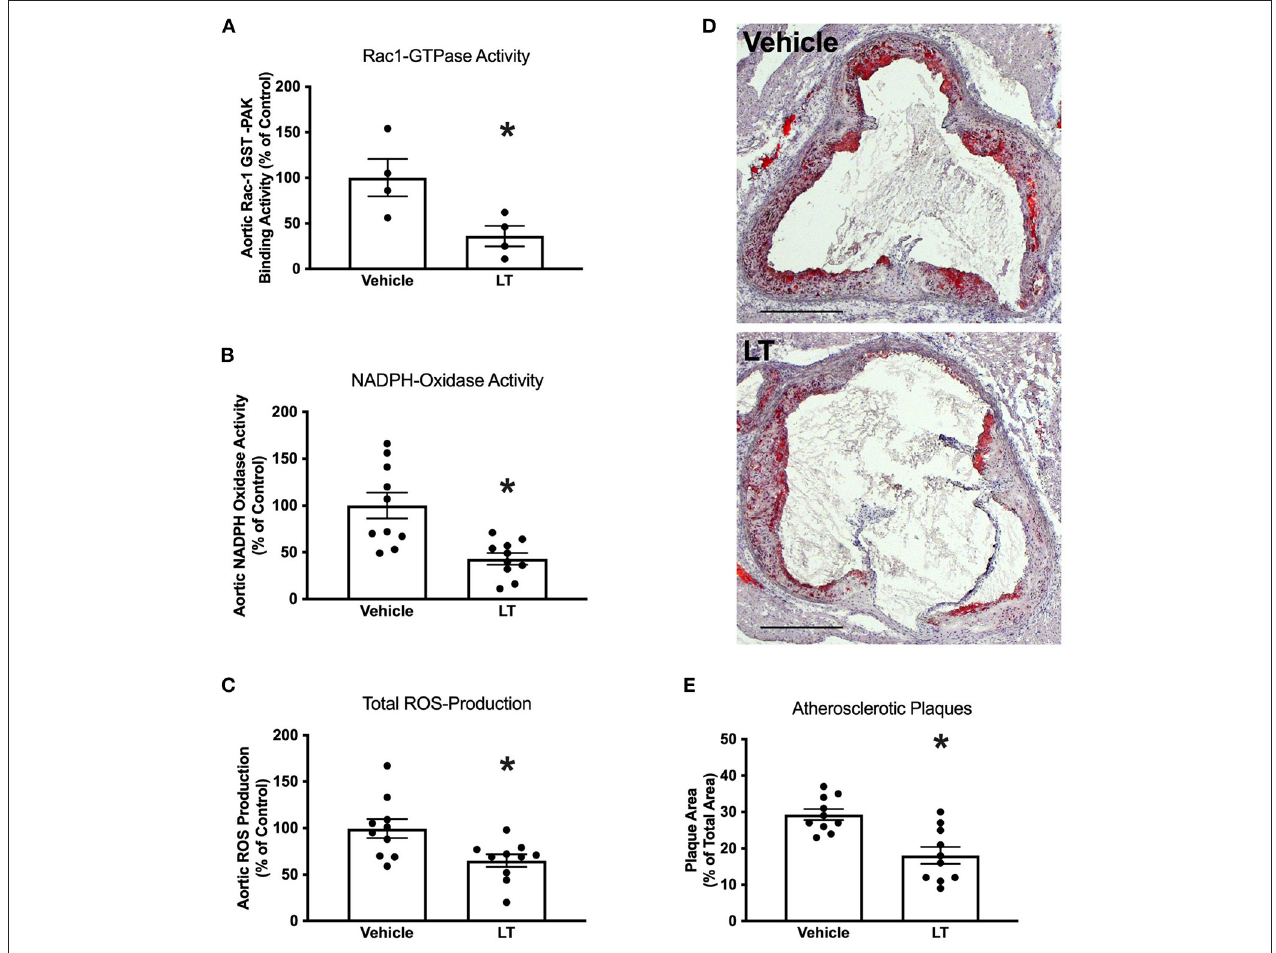
FIGURE 2 | Long-term Rac1 inhibition, oxidative stress and atherosclerosis. (A) Aortic homogenates of ApoE − / − mice that were fed a cholesterol-rich diet for 7 weeks and were concomitantly treated with 0.1 µ g LT/week via osmotic mini-pumps showed reduced Rac1 GTPase activity compared to vehicle-treated mice in a Rac1 GST-PAK pull-down assay (* p < 0.05, n = 4 per group). (B,C) LT-treated ApoE − / − mice displayed reduced aortic NADPH oxidase activity ( B , * p < 0.05, n = 10 per group) and aortic ROS production ( C , * p < 0.05, n = 10 per group), as measured by lucigenin-enhanced chemiluminescence and L-012 chemiluminescence, respectively. (D) Representative histological cross-sections of the aortic root stained with oil red O to display atherosclerotic plaques. LT-treated ApoE − / − mice showed decreased atherosclerotic plaque formation. (E) Quantification of atherosclerotic plaque formation, expressed as plaque area in percent of total area (* p < 0.05, n = 10 per group). Scale bars indicate